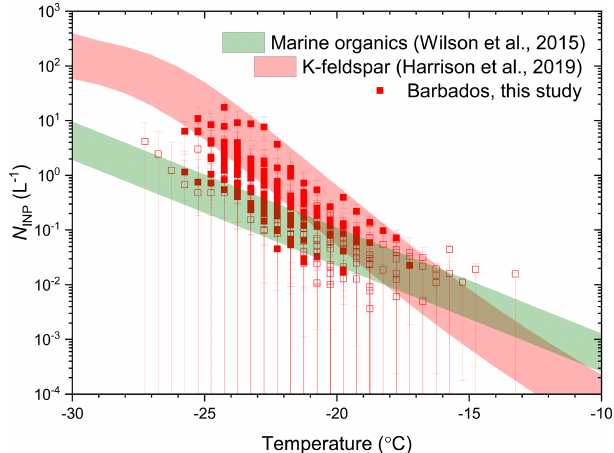
Figure 8. Ice-nucleating particle concentrations in Barbados com- pared with model predictions for marine organics (Wilson et al., 2015) and the K-feldspar component of desert dust (Harrison et al., 2019) for the campaign period. The model simulations were done with GLOMAP and are described in Vergara-Temprado et al. (2017), with the exception that the parameterization for K- feldspar from Atkinson et al. (2013) was replaced with that from Harrison et al. (2019). Open symbols indicate upper limits. The ranges indicate the variability through the campaign